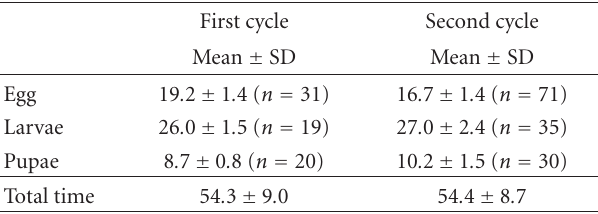
Table 1: Duration of the developmental immature stages of Omas- pides pallidipennis Boheman, 1854 (Chrysomelidae), for the first and second cycle in a fragment of Atlantic Forest (Floresta Nacional de Passa Quatro, Minas Gerais State,